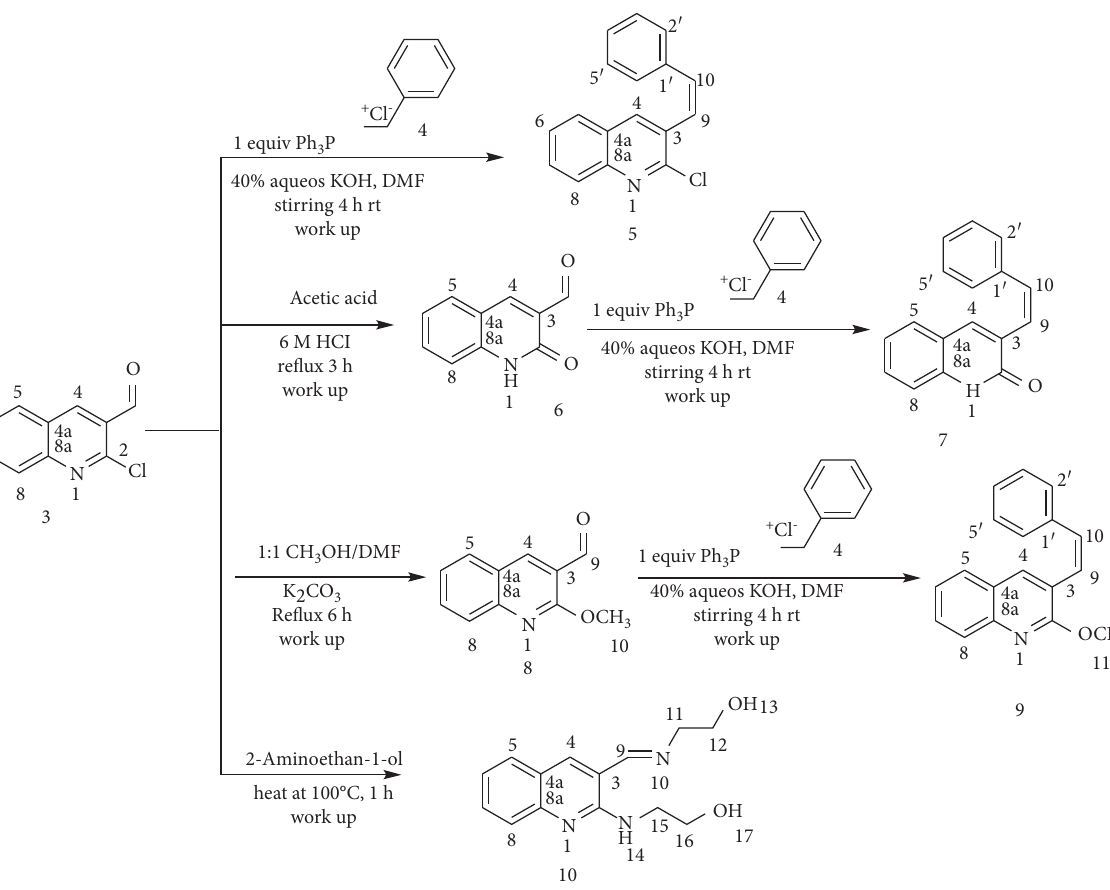
Scheme 1: Synthesis of 2-chloroqunoinoline